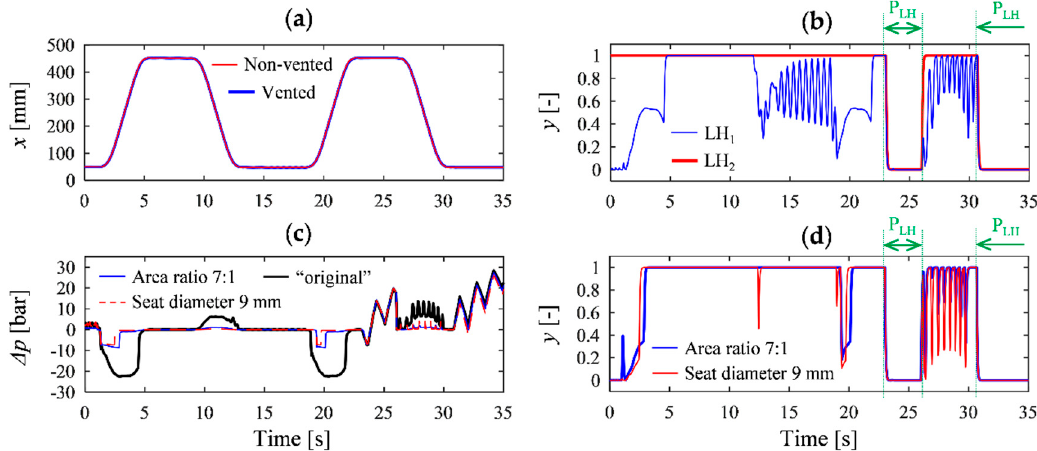
Figure 14. ( a ) Simulated piston position with vented and non-vented load-holding valves (area ratio 3:1 and seat diameter 5 [mm]); ( b ) simulated poppet lift using non-vented load-holding valves (area ratio 3:1 and seat diameter 5 [mm]); ( c ) simulated pressure drop across LH 1 using non-vented POCVs; and ( d ) simulated poppet lift of LH 1 using non-vented POCVs with modified settings.